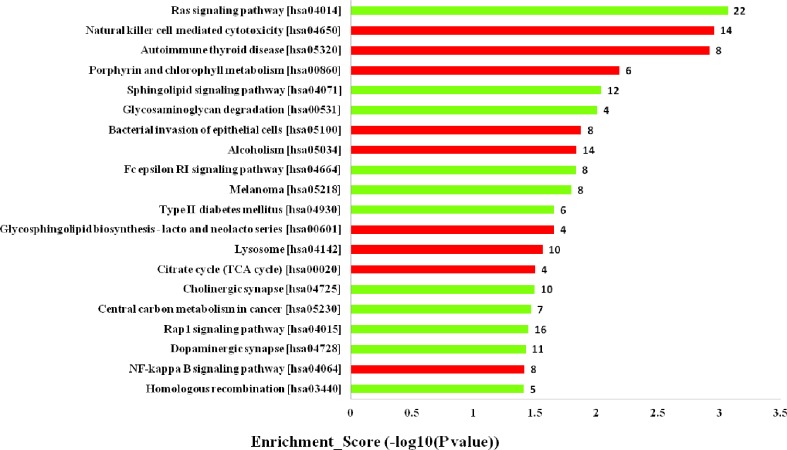
Kyoto Encyclopedia of Genes and Genomes (KEGG) pathways analysis. Top 20 pathways for the differences in long noncoding RNA (lncRNA) genes coexpressed in the dilated cardiomyopathy (DCM) and ischemic cardiomyopathy (ICM) patients. The red bars are associated with upregulated pathways, the green bars are associated with downregulated pathways. The bar plot shows the top 20 enrichment score [−log10(p-value)] value of the significant enrichment gene ontology terms.